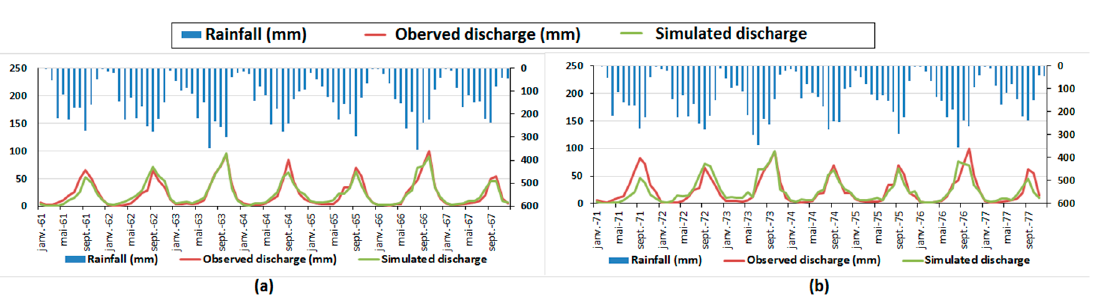
Figure 6. Hydrograms observed and simulated by the GR2M model at Soubré: ( a ) calibration; ( b ) validation.